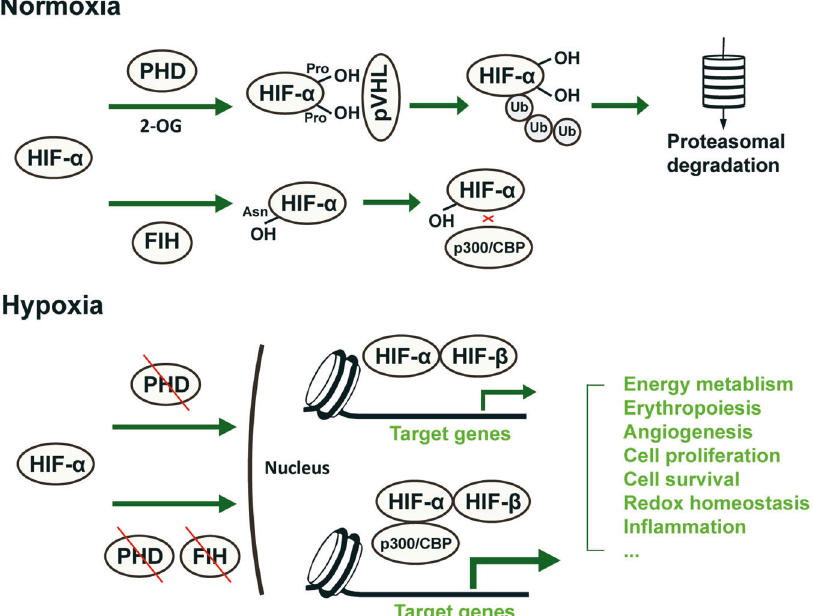
Fig. 1 Schematic illustration of the posttranslational regulation and function of HIF. HIF is the principal transcription factor mediating adaptation to oxygen tension, regulating a wide variety of biological processes, such as energy metabolism, erythropoiesis, angiogenesis, redox homeostasis, in fl ammation response, cell proliferation and survival. It is a heterodimer composed of a hypoxiasensitive HIF α subunit and a constitutively expressed HIF β subunit. HIF1 α and HIF2 α are constantly hydroxylated by PHD1-3 at speci fi c prolyl residues in an oxygen- and 2-OG-dependent process and targeted for proteasomal degradation, whereas during hypoxia, they dimerize with HIF β to bind to DNA sequences and regulate gene expression. In more severe hypoxia, asparaginyl hydroxylation of HIF- α by FIH is inhibited, and increased interaction of HIF with the transcriptional coactivators p300 and CBP further promotes target gene expression. PHD prolyl hydroxylase domain protein. 2-OG oxoglutarate. FIH factor-inhibiting HIF. CBP CREB-binding